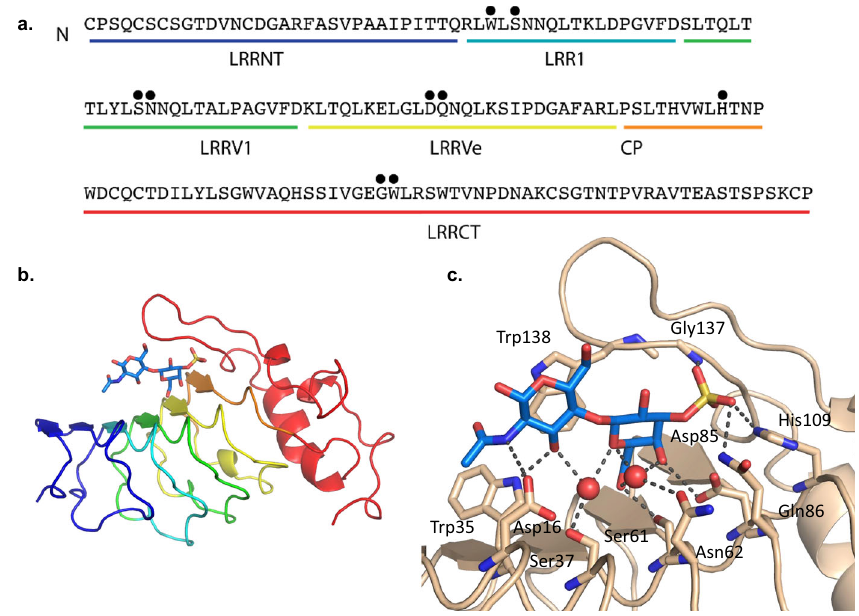
Fig. 2 Co-crystal structure of VLR O6 with (3 S)Gal β 1-4GlcNAc reveals the interactions and mode of glycan recognition. a Amino-acid sequence of VLR O6 with amino acids that come into contact with antigen indicated with a black circle. b Co-crystal structure of VLR O6 and ligand. c Detailed view of glycan interactions in b within the antibody binding